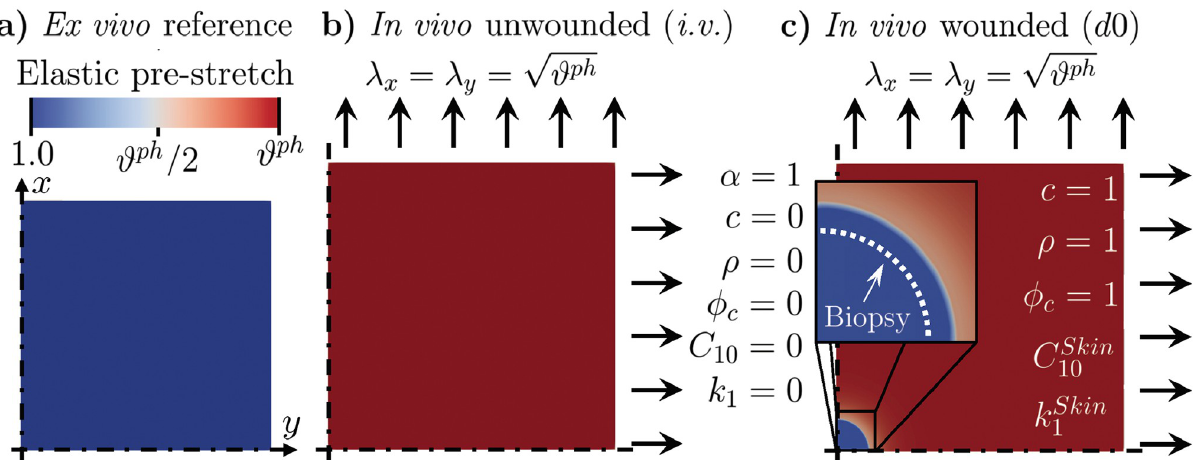
Fig 3. Model preparation before solving the wound healing problem. ( a ) Modeled square tissue patch, with symmetric boundary conditions along x = 0 and y = 0 and mechanical constitutive parameters corresponding to unwounded skin. ( b ) Unwounded skin patch in its in vivo state ( i.v. ), characterized by an equi-biaxial pre-stretch. ( c ) Wound infliction in vivo , obtained by setting the mechanical parameters in a circular tissue region to extremely small values; the values of the biochemical and microstructural quantities ( α , c , ρ , ϕ c ) are also adjusted to reflect a freshly-wounded tissue. Note that, immediately after infliction, the wound enlarges due to the corresponding release of tissue pre-stretch, as shown in the inset (white dashed line vs. boundary of the blue region). The reached deformation is made permanent to ensure that the newly-deposited tissue has no initial